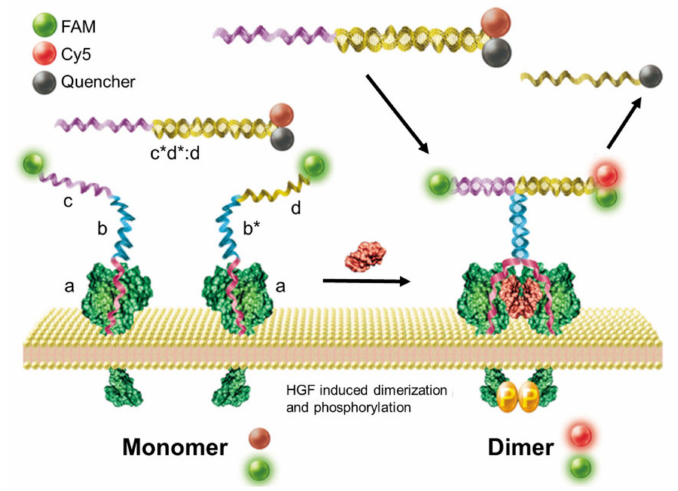
Figure 8. Design of a fluorescent biosensor based on proximity-induced displacement for monitoring protein dimerization. Adapted with permission from J. Am. Chem. Soc. 2018, 140, 4186–4190, doi:10.1021/jacs.7b11311. Copyright (2018) American Chemical Society